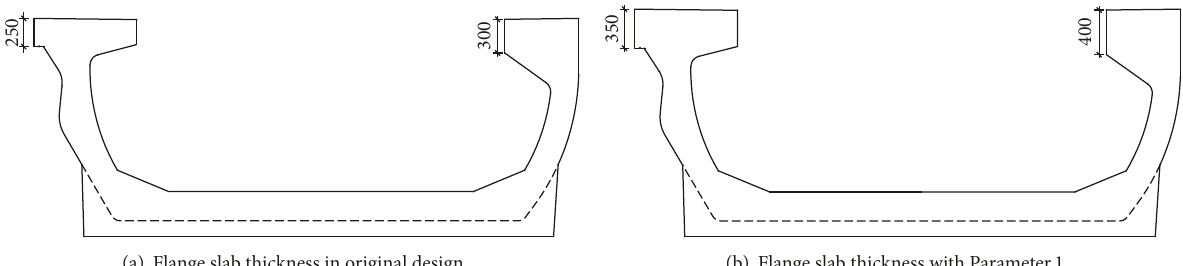
Figure 14: Thickness of flange slab comparison (unit: mm).